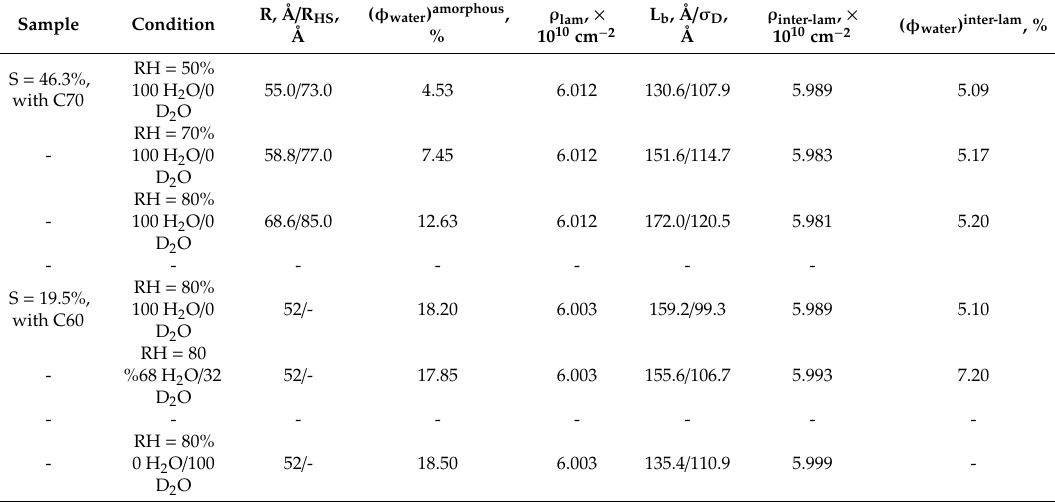
Table 2. The structural and scattering parameters of the hydrated and lamellar morphologies delivered by the model interpretation of the experimental data according to Equations